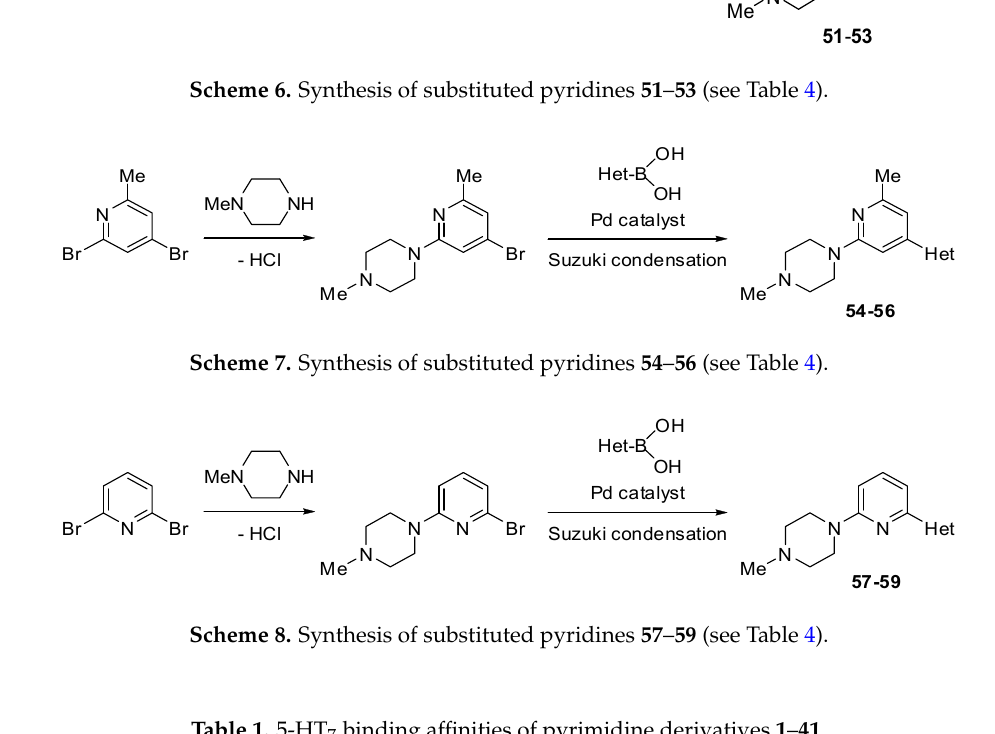
Table 1. 5-HT 7 binding affinities of pyrimidine derivatives 1 – 41 .